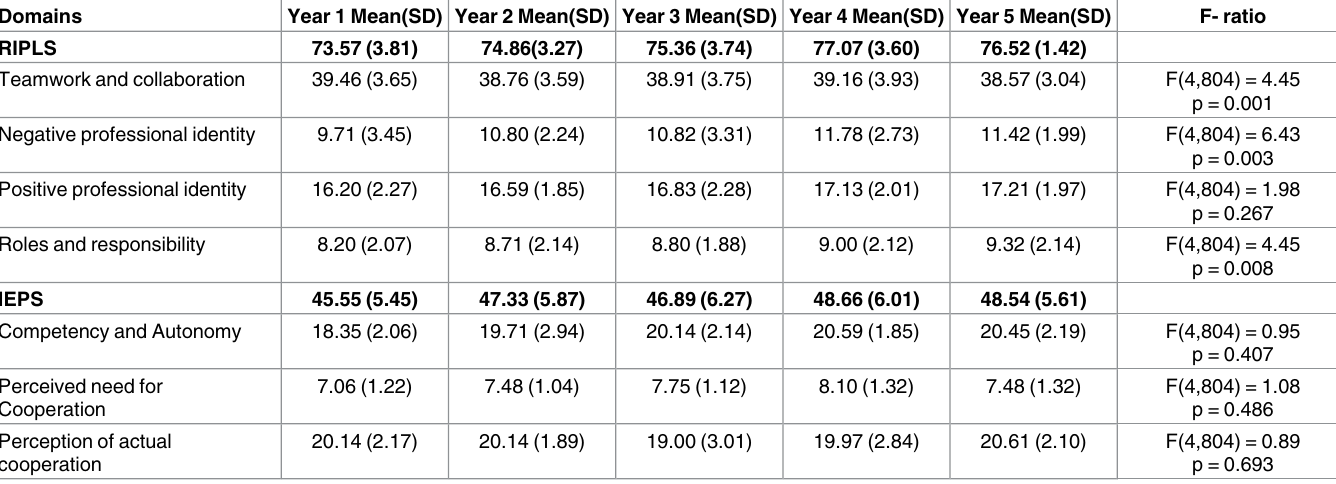
Table 5. RIPLS and IEPS domain scores for different year of study (mean and standard deviation).